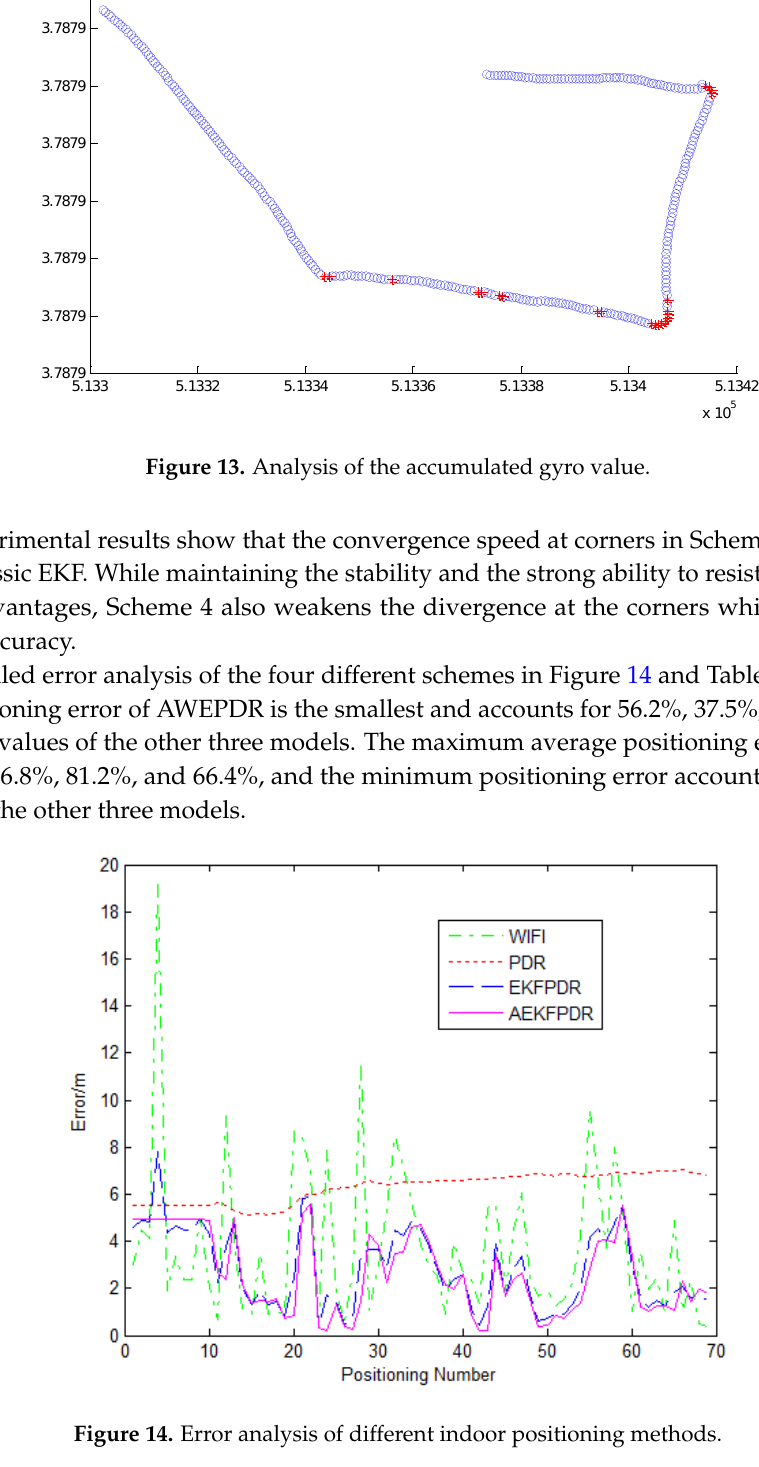
Figure 12. Analysis of the accumulated gyro value.